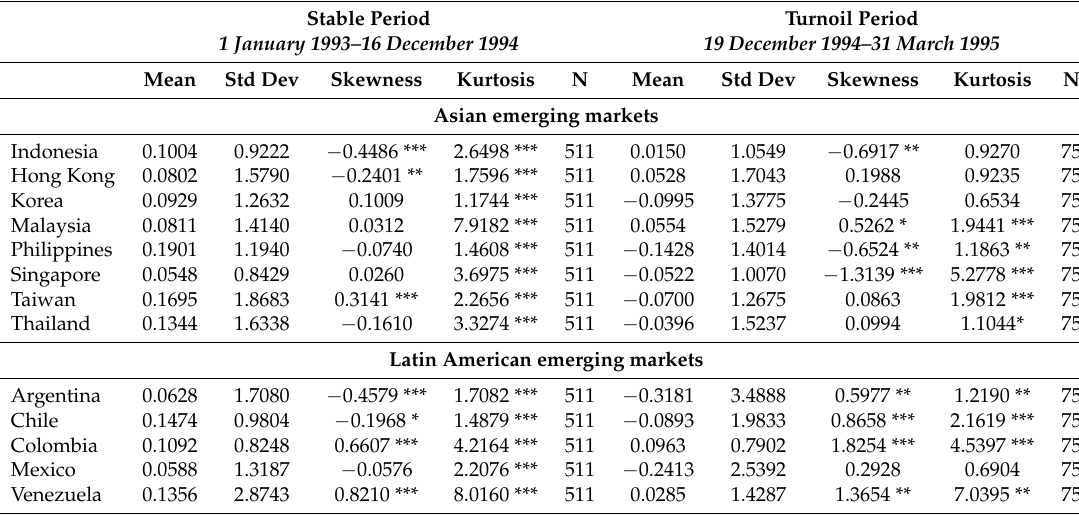
Table 1. Descriptive statistics on stock returns: The Mexican